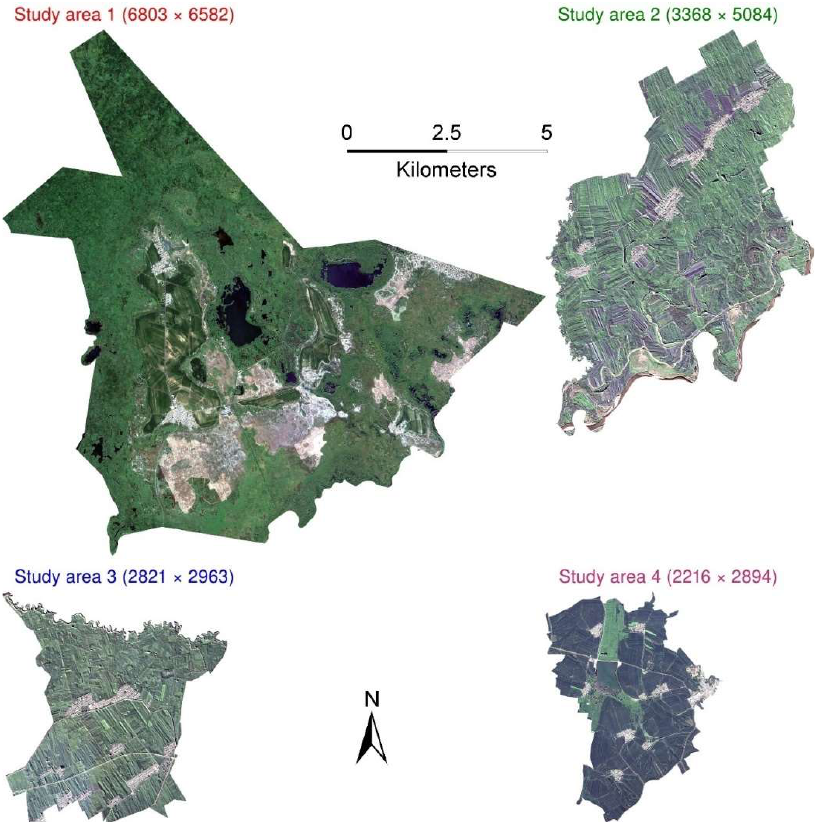
Figure 2. Four study area (locations shown in Figure 1) GaoFen-1 true color images with 6803 × 6582, 3368 × 5084, 2821 × 2963 and 2216 × 2894 2 m pixels. Their sizes are proportional to their areas.